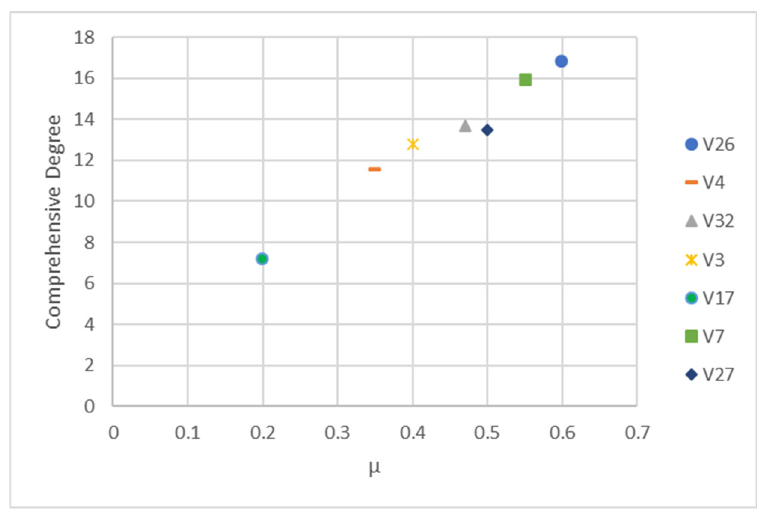
Figure 10. Comprehensive degree